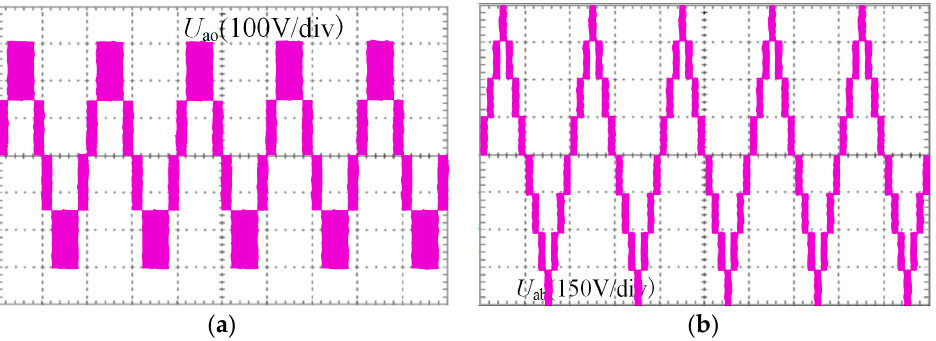
Figure 9. Phase voltage and line voltage of the inverter; ( a ) Phase voltage of the inverter; and ( b ) Line voltage of the inverter.